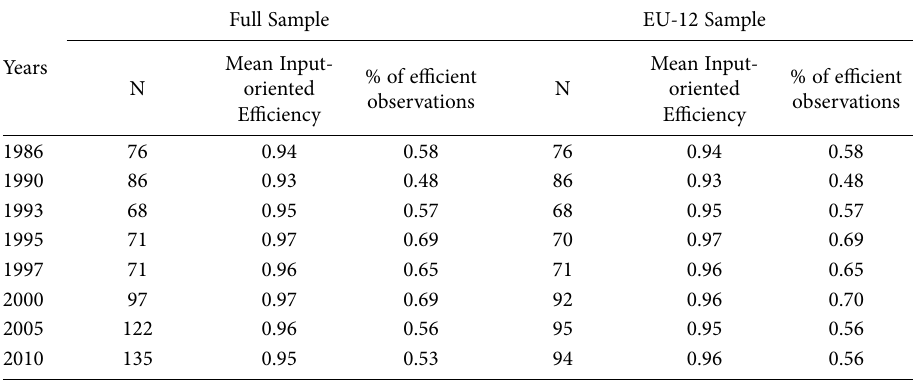
Source: Own elaborations on FADN and FSS